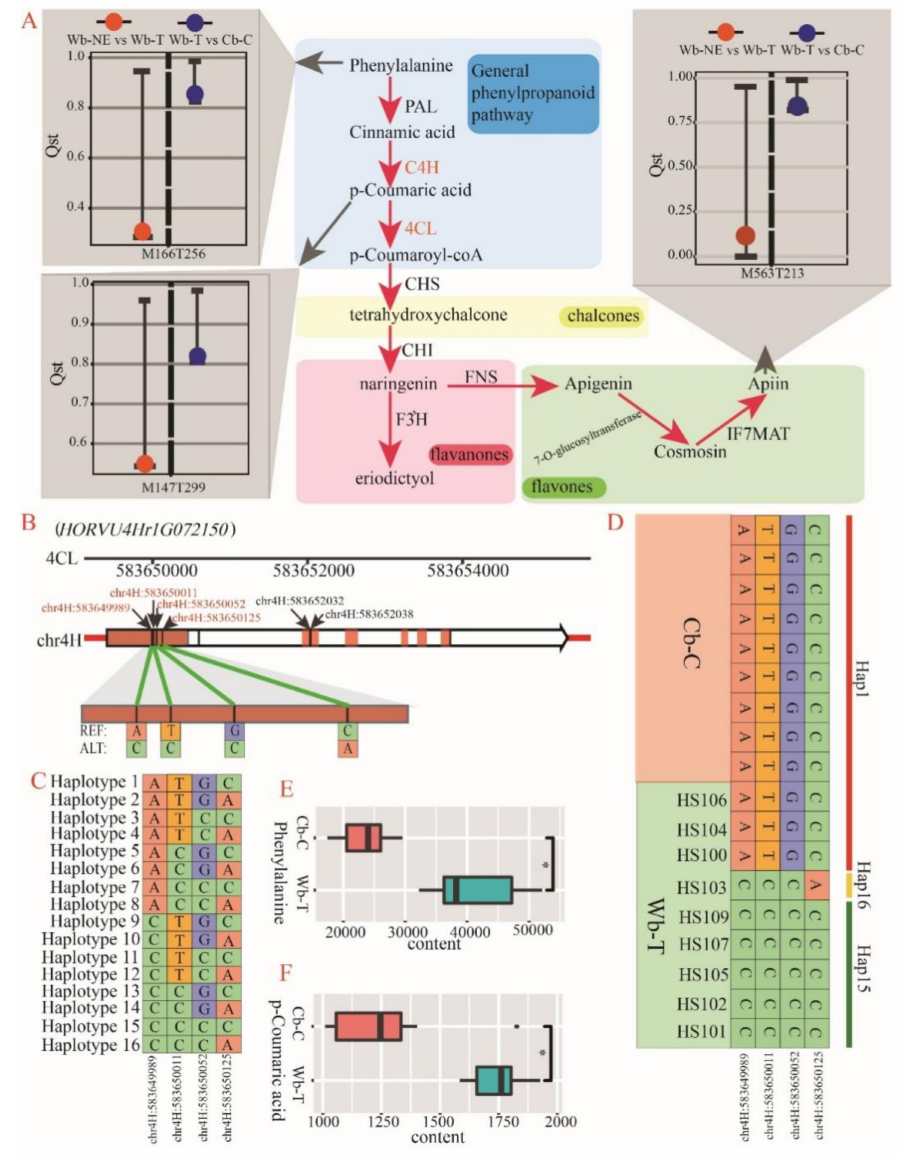
Figure 7. HORVU4Hr1G072150 , a key gene regulating phenylpropanoid metabolites, and its haplo- type distribution. Wb-NE, wild barley from the Near East Fertile Crescent. Wb-T, wild barley from the Tibetan Plateau. Cb-C, cultivated barley from China. ( A ) Phenylpropanoid metabolic pathway. PAL, phenylalanine ammonia-lyase. C4H, trans-cinnamate 4-monooxygenase. 4CL, 4-coumarate-CoA ligase. Bars and dots represent 99% CIs of Qst and observed Qst, respectively. ( B ) Gene structure of HORVU4Hr1G072150 , the red regions represent the coding region of the gene. The vertical lines in the gene indicate the positions of SNPs. The ruler above the gene indicates the position of the gene on 4H chromosome. ( C ) 16 haplotypes composed of 4 missense SNPs in HORVU6Hr1G027650 . ( D ) Three detected haplotypes in accessions of Cb-C and Wb-T. ( E , F ) Comparison of contents of Phenylalanine ( E ) and 4-Hydroxycimamic ( F ) between Cb-C with haplotype 1 (nine accessions) and Wb-T with haplotype 15 (five